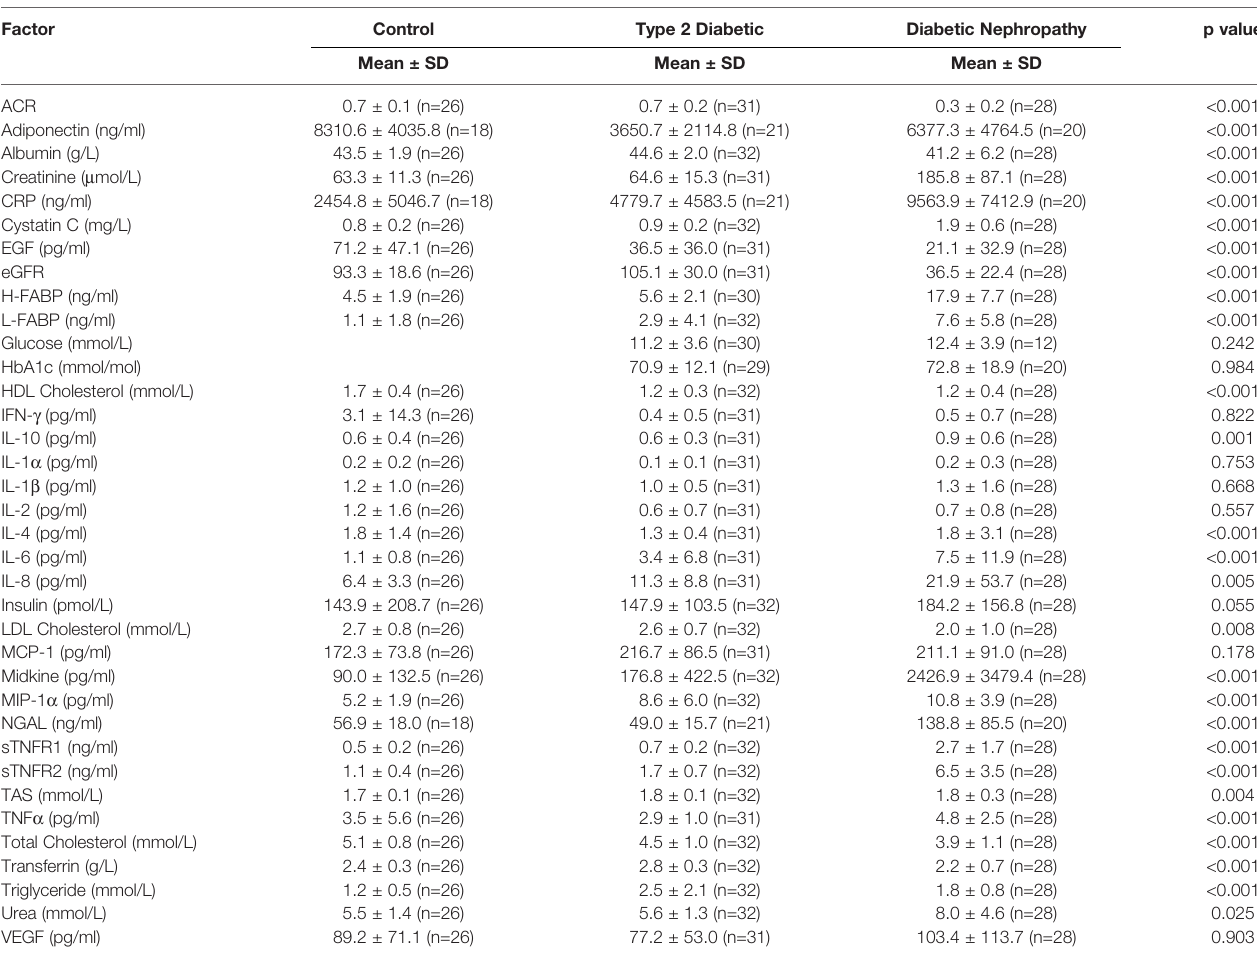
TABLE 2 | Serum biomarkers (mean ± SD).